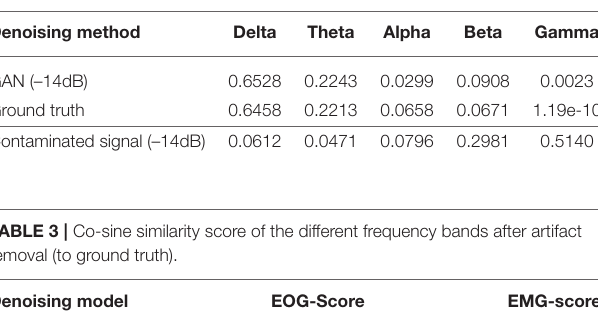
TABLE 2 | Power ratios of different frequency bands before and after EMG artefact removal.